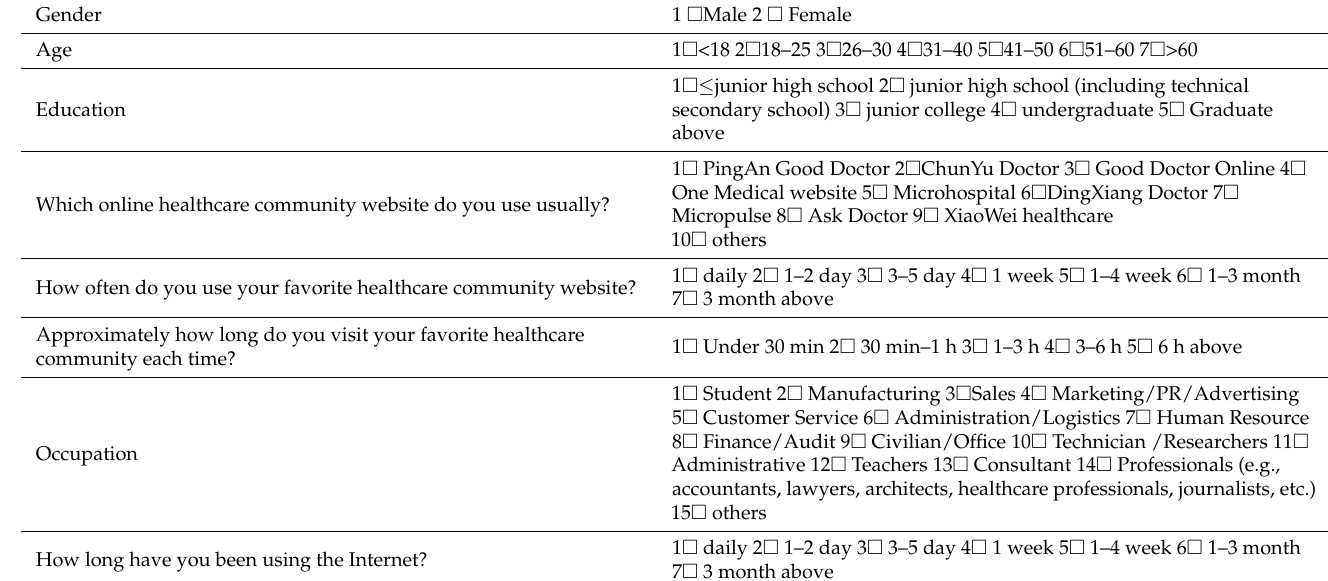
Table A1. Measurement of sociodemographic variables and variables concerning information searching behavior towards